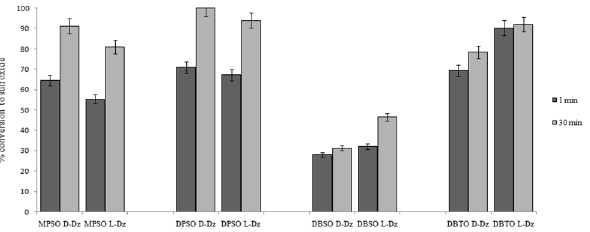
Fig 2. Oxidation of sulfides. Percentage conversion to sulfoxide after 1 and 30 minutes of reaction in the presence of 12 μ M of D or L-DNAzyme and 4 mM H 2 O 2 . Concentration of substrates was 2.5 mM for thioanisole (MPS), 0.1 mM for diphenyl sulfide (DPS), 0.25 mM dibenzyl sulfide (DBS), and 0.15 mM for dibenzothiophene (DBT).